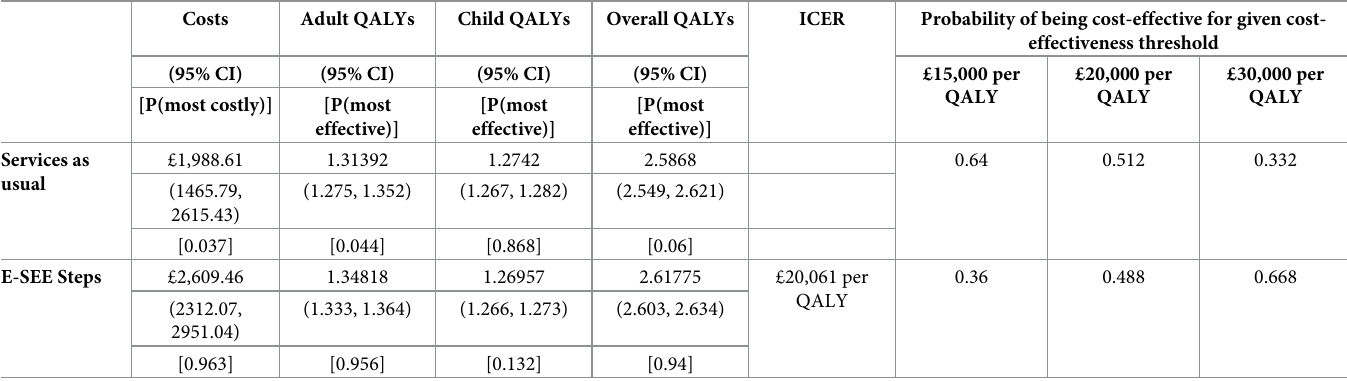
Table 3. Cost-effectiveness results.